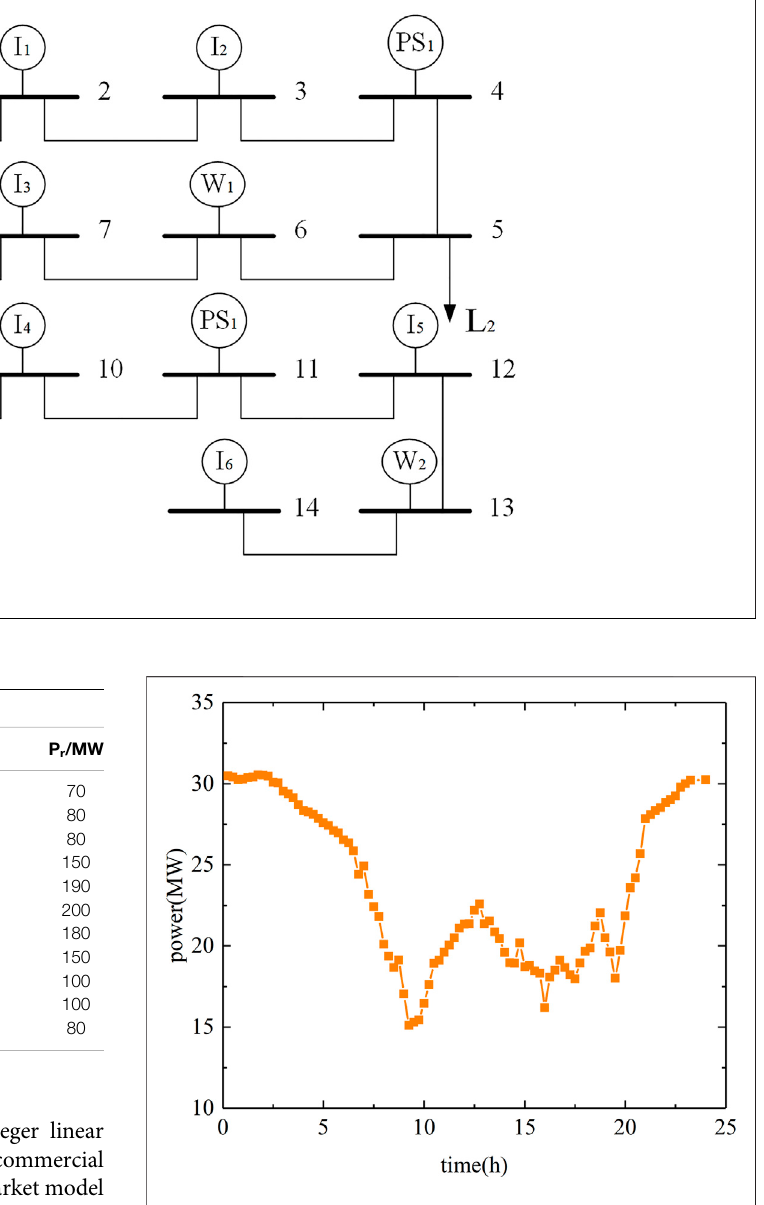
FIGURE 2 | Typical daily wind power generation